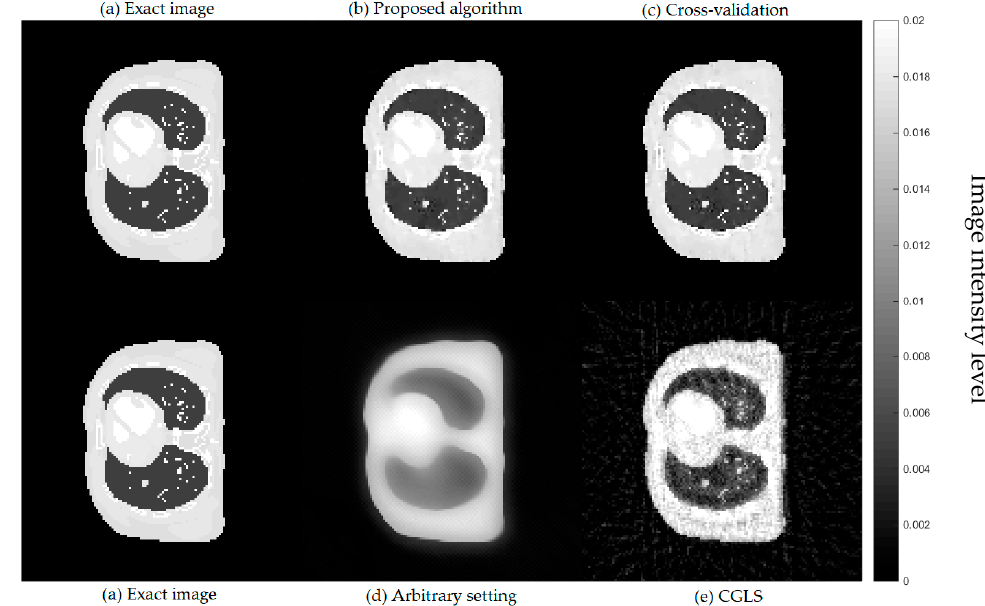
Figure 4. Cross-sectional slices of reconstructed images from 50 projection views obtained from four cases: ( a ) exact image; ( b ) the proposed algorithm; ( c ) cross-validation; ( d ) arbitrary setting; ( e ) CGLS. The display window is [0–0.02].